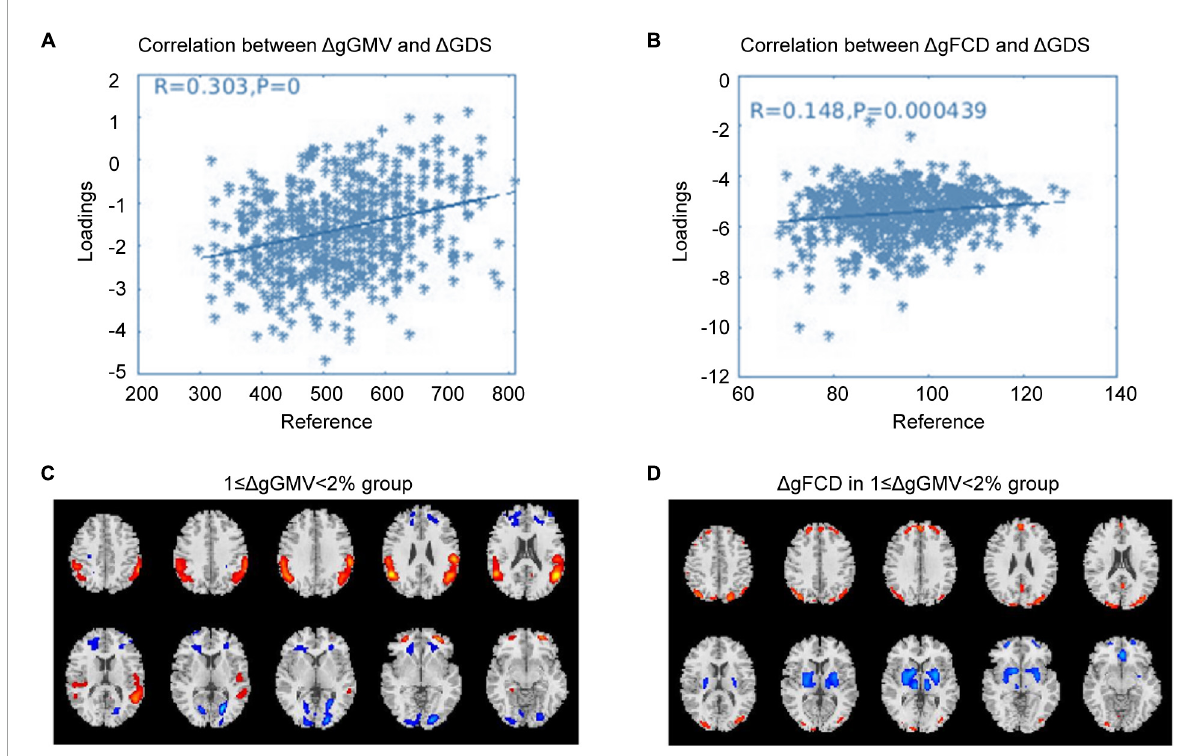
FIGURE2 The correlation between (cid:49) GMV/ (cid:49) gFCD and cognitive deterioration in the moderate whole-brain alteration group. Correlation analysis was carried out to evaluate the relationship between subsequent cognitive decline after two years of antipsychotic treatment and baseline (cid:49) gGMV/ (cid:49) gFCD in the drug-naïve first-episode schizophrenia with 1 ≥ (cid:49) wGMV < 2% at baseline in the moderate whole-brain alteration group. (A) Relationship between (cid:49) gGMV and (cid:49) GDS; (B) Relationship between (cid:49) gFCD and (cid:49) GDS; (C) The moderate whole-brain alteration group with 1 ≥ (cid:49) wGMV < 2% at baseline; (D) (cid:49) gFCD in the moderate whole-brain alteration